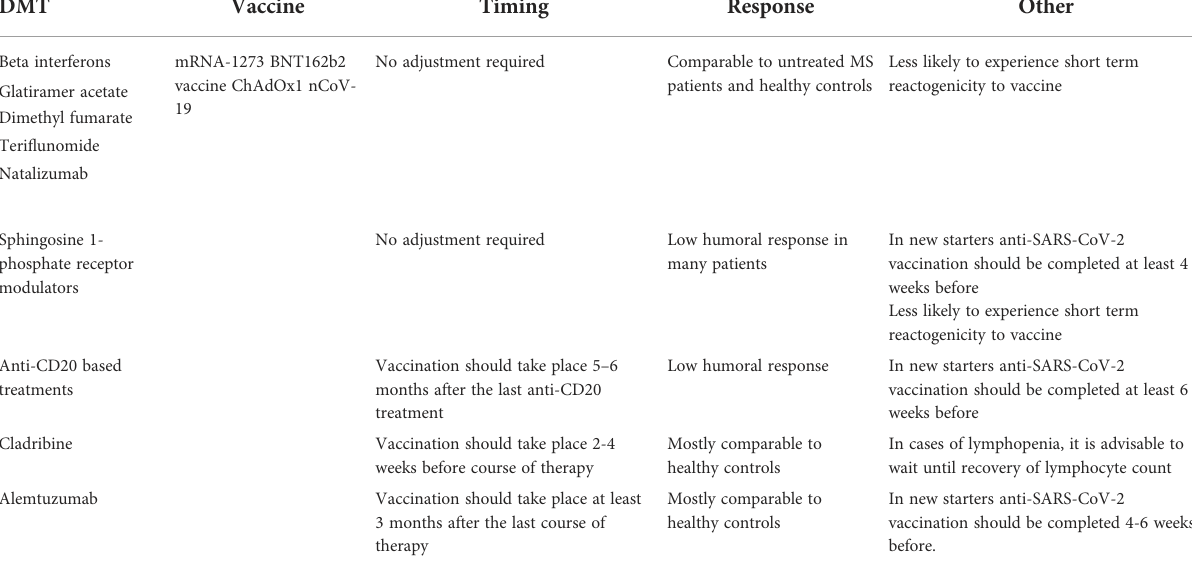
TABLE 1 DMT, vaccination response and timing